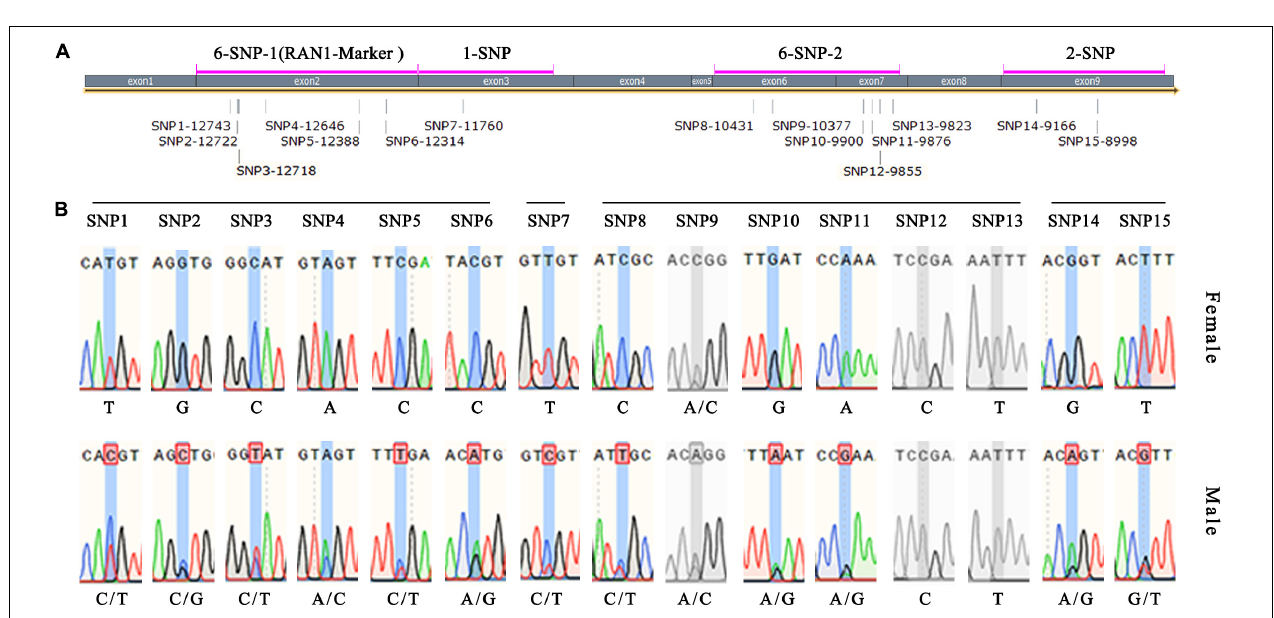
FIGURE 6 | Verification of FcRAN1 SNP-specific primers. (A) Amplification interval of the SNP identification primers and number of covered SNP sites. (B) Sex-identification capacity of 15 SNP sites validated by 51 fig cultivars of known sex. Gray color indicates invalid SNPs.